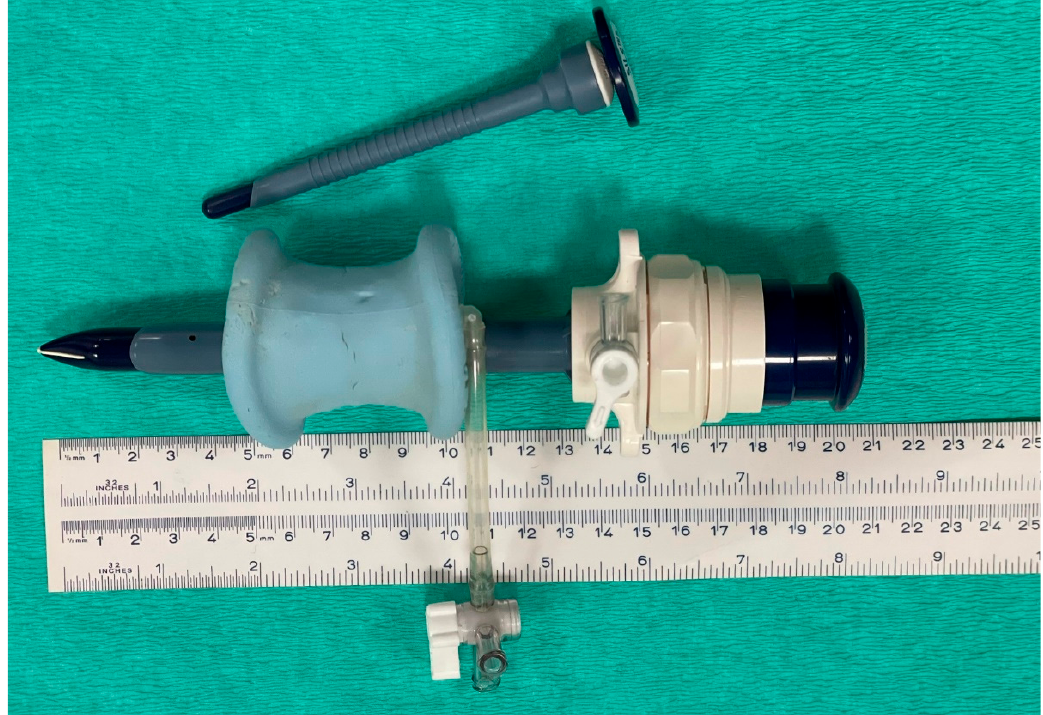
Figure 3. Device used in Group D. Single-port access system was used for one of the two methods included in group D: conformable device (blue foam) that adapts to the incision and seals it, presenting three orifices, one to insert a cannula (12 mm diameter, 11 cm length) for the endoscope and two for 5 mm instruments (at the top of the picture, not inserted in the foam).